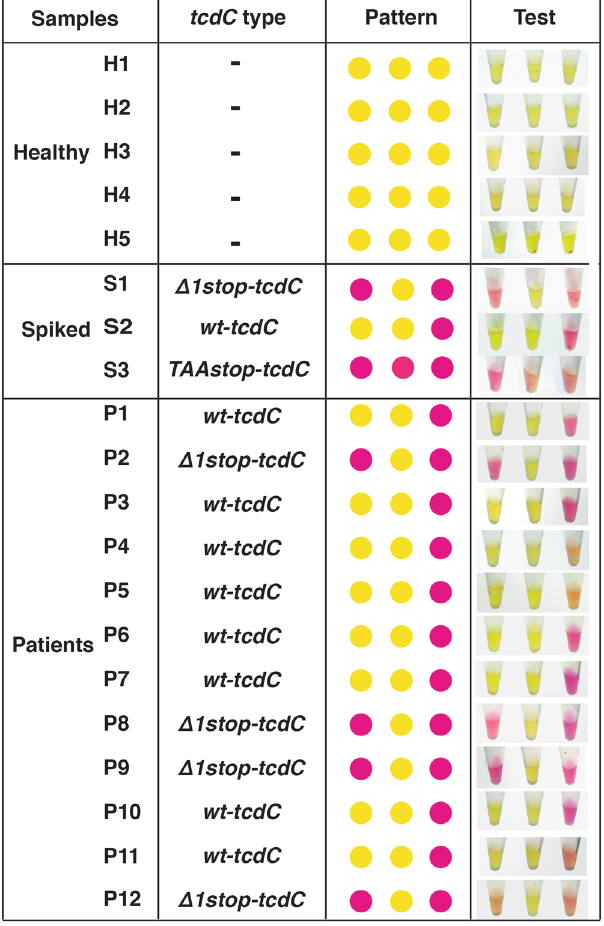
Figure 5. PCR-litmus test with DNA from stool samples. The tcdC gene information was acquired by DNA sequencing. The photographs of test were taken at 30